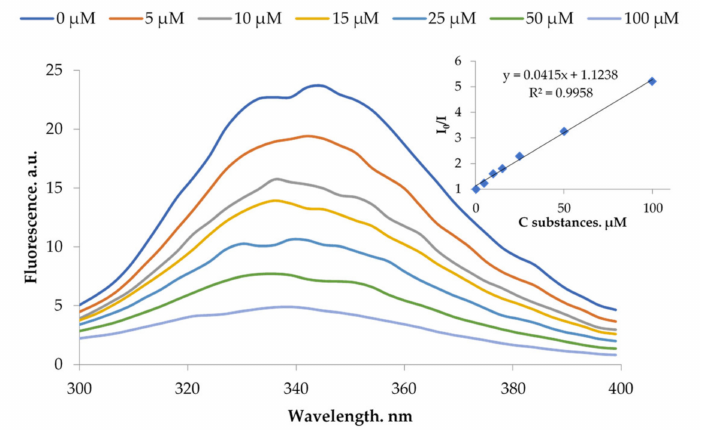
Figure 4. Fluorescence spectra of BSA ( λ ex = 345 nm) in complexes with Na (3g) (5 × 10 − 5 –1 × 10 − 4 M, pH 8.0). Inset: Fluorescence quenching in Stern–Volmer coordinates.